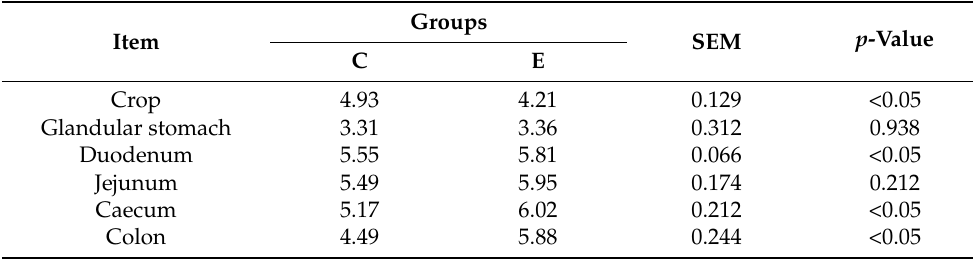
Table 4. pH value of selected sections of the gastrointestinal tract of turkeys.